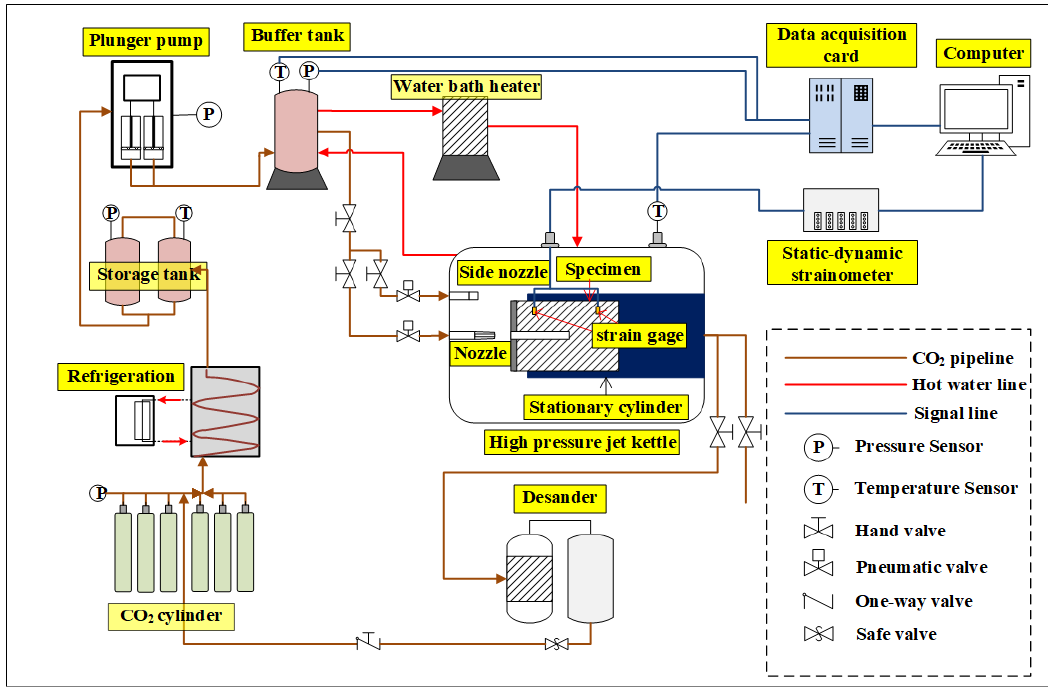
Figure 3. A schematic diagram of the SC-CO 2 jet fracturing experimental system.